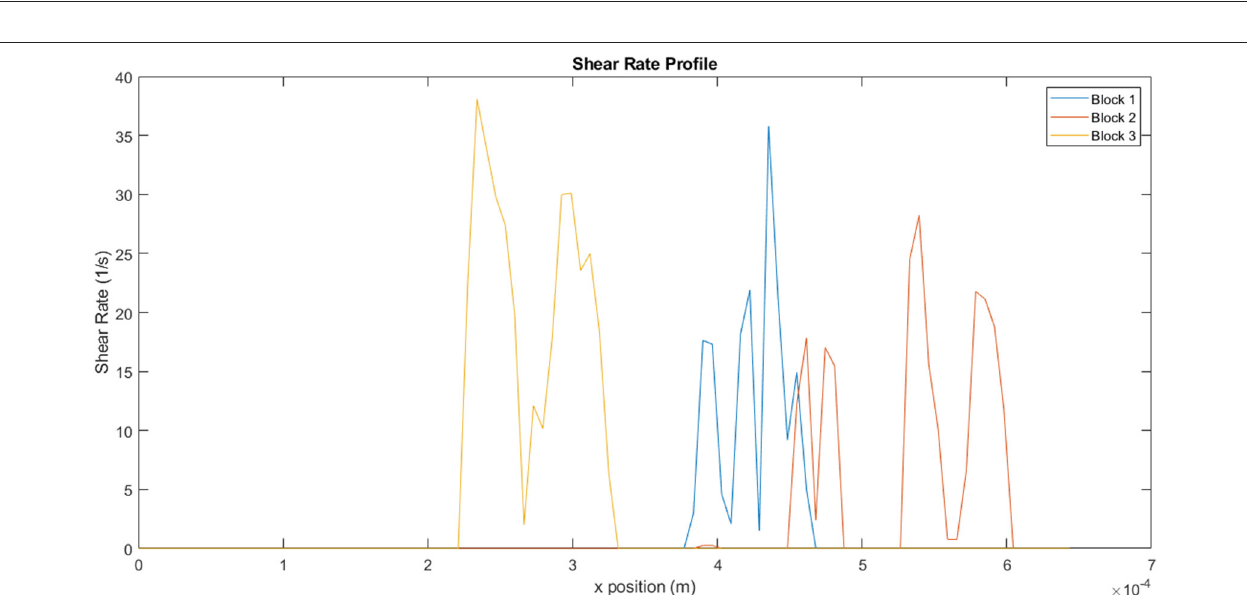
FIGURE 12 | Velocity profiles for the different blocks taken from a line on the xy mid-plane, as indicated in Figure 11 .